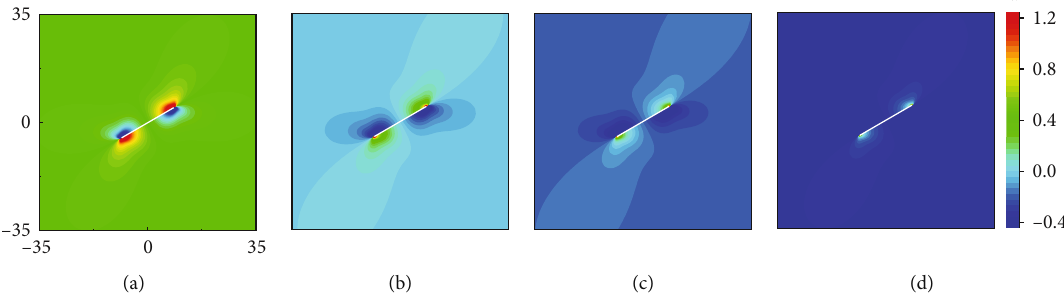
Figure 16: The contour plot of normalized σ